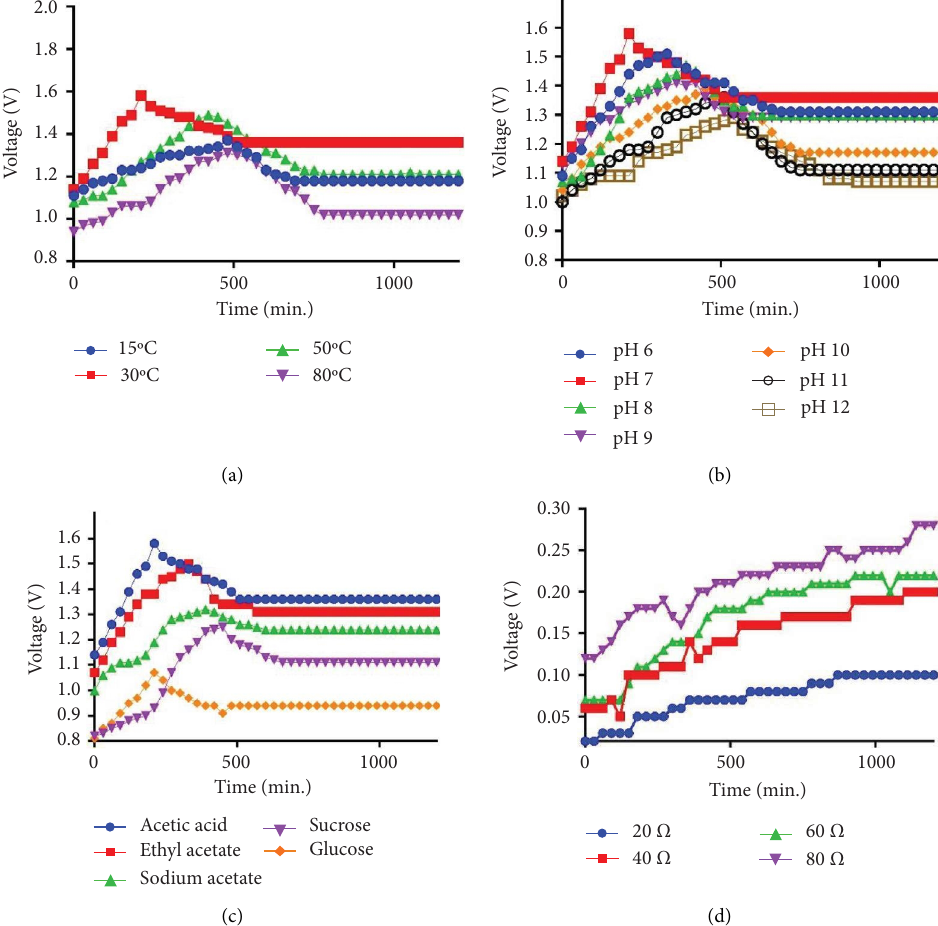
Figure 5: Comparison of voltage at various (a) temperatures, (b) pH values, (c) substrates, and (d) resistances.